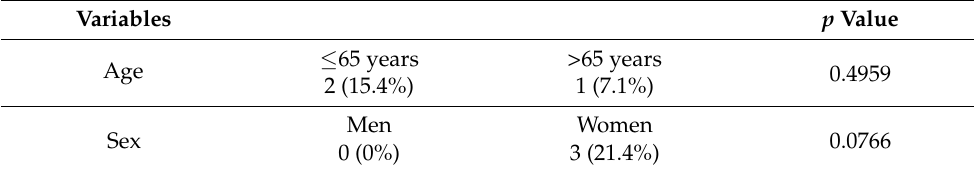
Table 4. Distribution of patients with simultaneous maxillary sinus lift ( n =